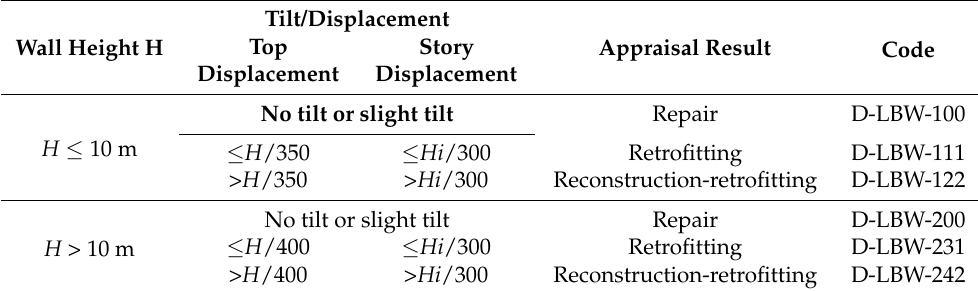
Table 4. Coding guidelines for deformation in load bearing wall.